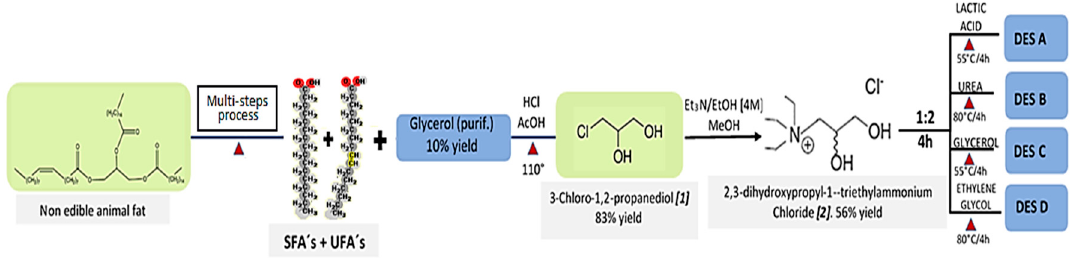
Figure 1. The process to prepare four novel bio-based DESs.